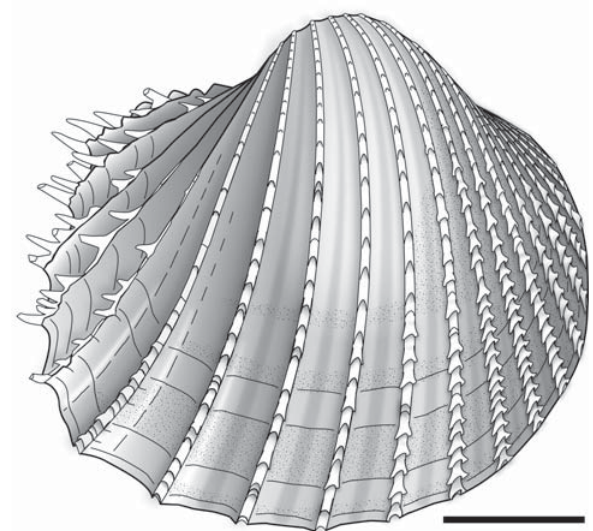
Fig. 14. Cardiid bivalve Procardium jansseni sp. nov. Graphic reconstruc- tion of a right valve based on 12 fragments from Langhian (Miocene), The Netherlands, Miste, and Beringe. Fragments covering the majority of valve surface. Scale bar 20